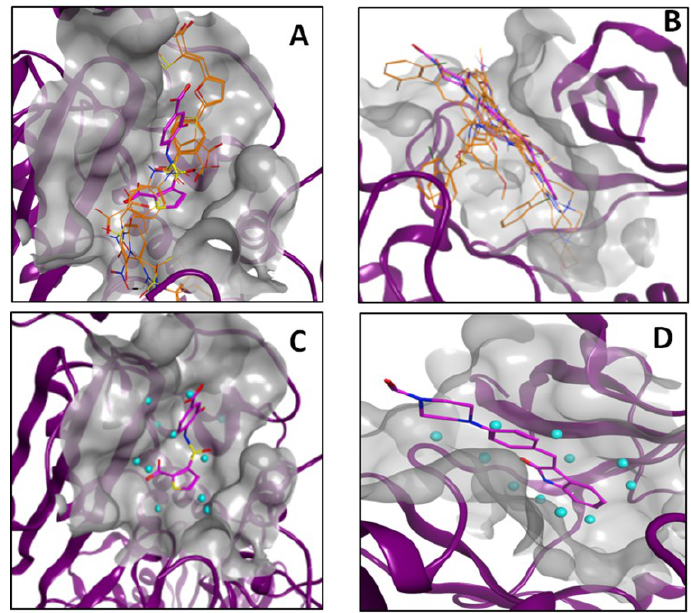
(panel A ) and FGFr1 (panel B ); The cyan spheres depicted in Panels ( C ) and ( D ) represent binding sites patches, generated by PL-PatchSurfer, that correspond to productive protein–ligand interactions observed in crystal structures of AmpC (PDB ID: 1XJG) and FGFr1 (PDB ID: 1AGW), respectively; The green spheres highlighted in panels E and F are the ligand patches (for a related AmpC-active and FGFr1-active ligand, respectively) that are matched by PL-PatchSurfer to the binding site patches, showing good coverage of the protein-ligand surface interaction